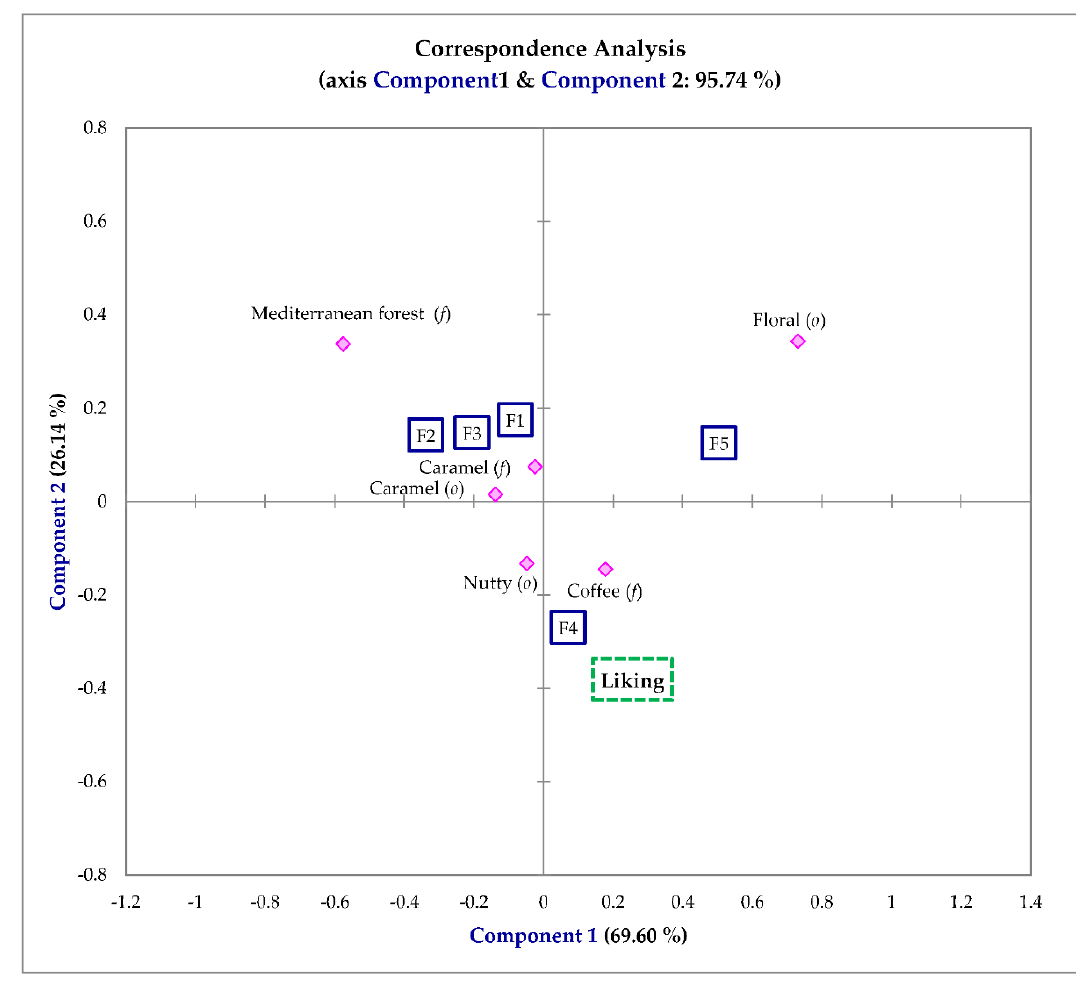
Figure 1. Differences among the samples according to the CATA descriptors used to study the Fondillón samples under study (Correspondence Analysis). Legend: wine samples; sensory attributes. --- consumers ‘overall liking.